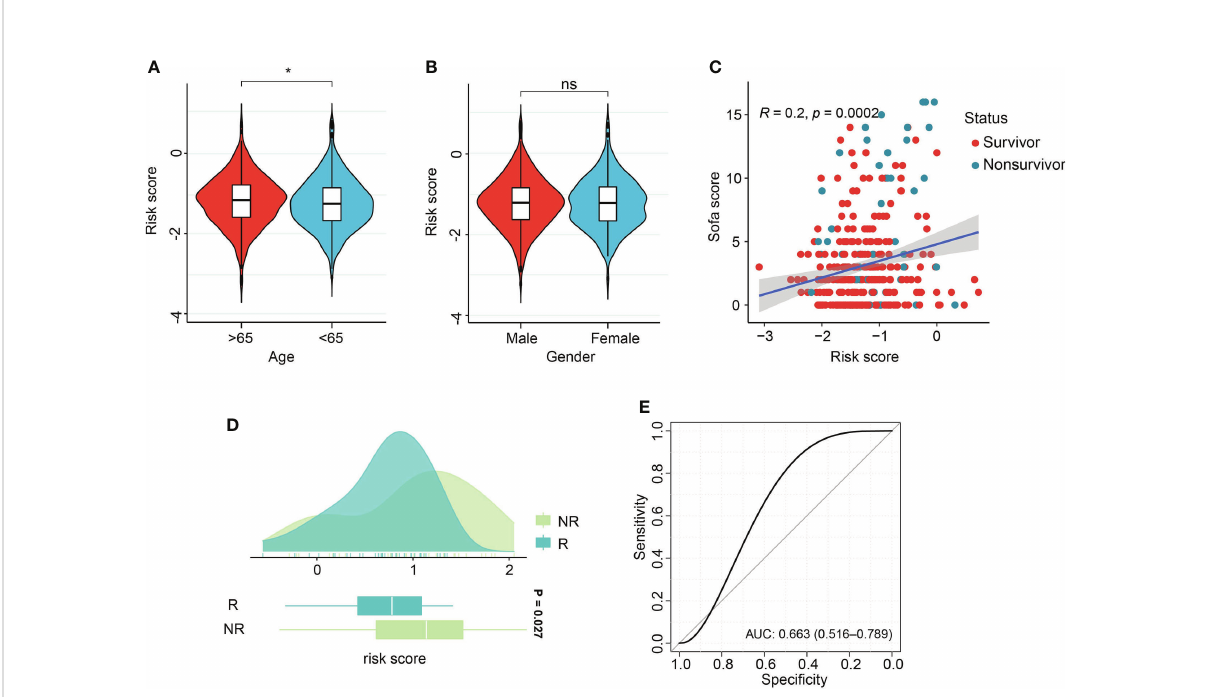
FIGURE 8 Association of risk score with clinical features and therapeutic response. (A, B) Violin plot of association of risk score with age and gender of sepsis patients. (C) Scatter plot of Pearson correlation analysis of risk score and sequential organ failure assessment (SOFA) score. (D) Box density plot of risk score with clinical therapeutic response. (E) ROC curve of performance of risk score in predicting early supportive therapy. *p < 0.05; ns, not signi fi